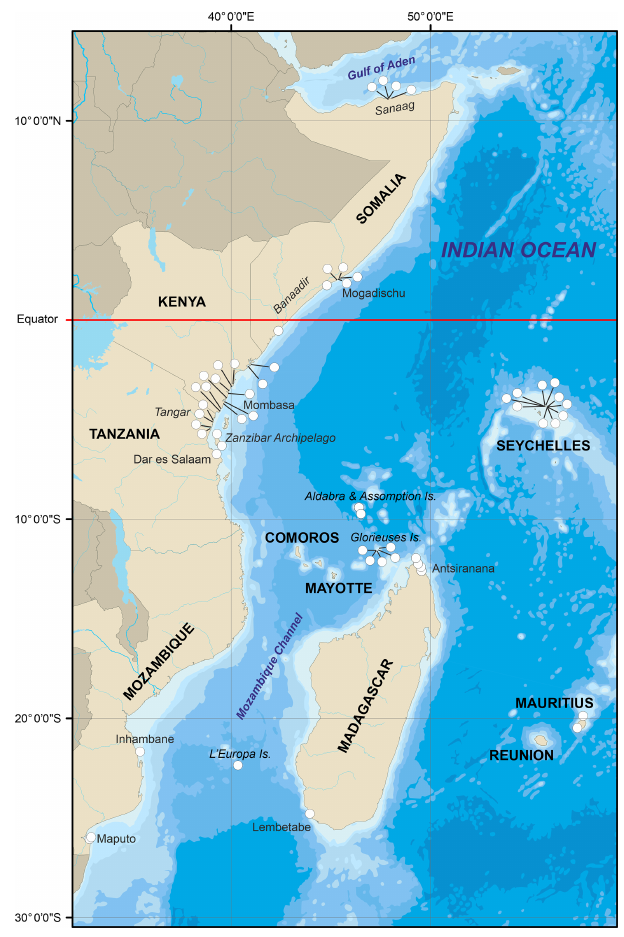
Figure 2. Overview map showing the distribution of PRSL prox- ies and their respective indicator types. Base map data compiled from Natural Earth; vector and raster map data at https://www. naturalearthdata.com/ (last access: 11 February 2021). An interac- tive map of the EAWIO data is available in the